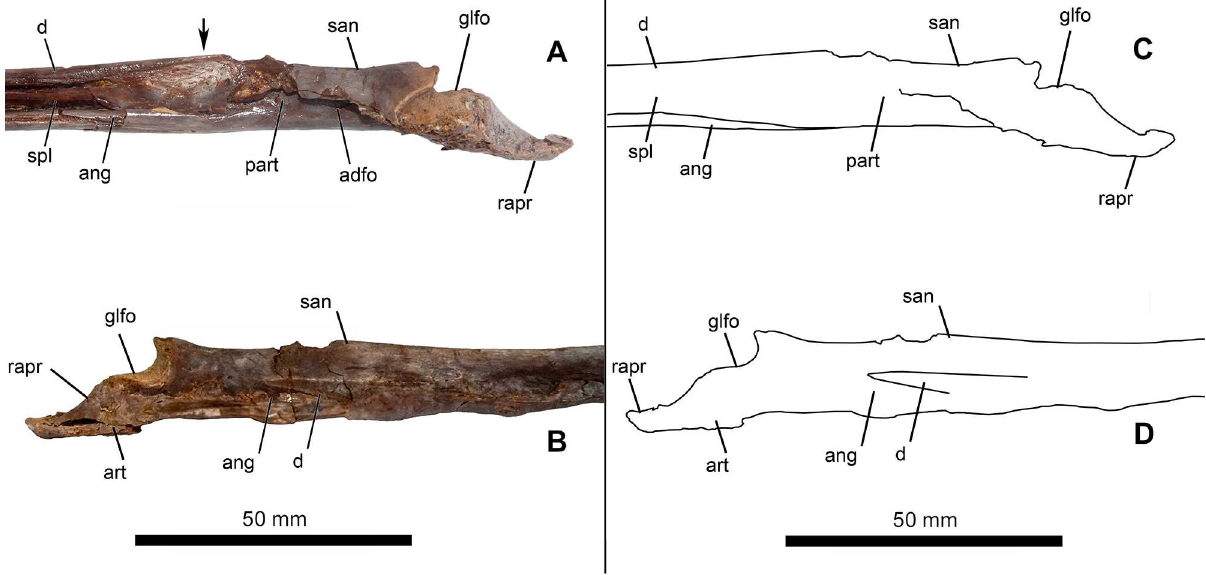
Fig 2. Rightmandibular ramus of Aymberedactyluscearensis gen.et sp. nov. (MN 7596-V). (A) Medialview. Arrow indicatesrugose surface. (B) Lateralview. (C) Schematicdrawing of the ramus in medialview. (D) Schematicdrawing of the ramus in lateralview. Abbreviations: adfo = adductorfossa, ang = angular, art= articular,d = dentary, glfo = glenoidfossa, part= prearticular, rapr = retroarticular process, san = surangular, spl = splenial.